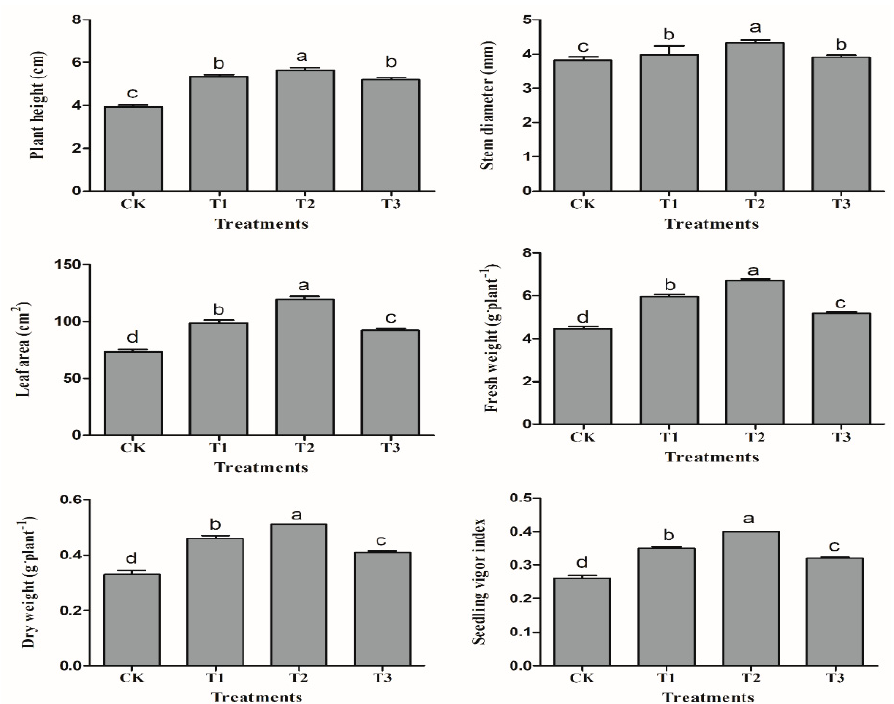
Figure 1. E ff ect of exogenous ALA application on growth of cucumber seedlings under low-temperature and weak-light stress. Data are the means of four replicates; error bars indicate the standard deviation. Treatments with the same lower-case letter are not significantly di ff erent (least significant di ff erence test, p =